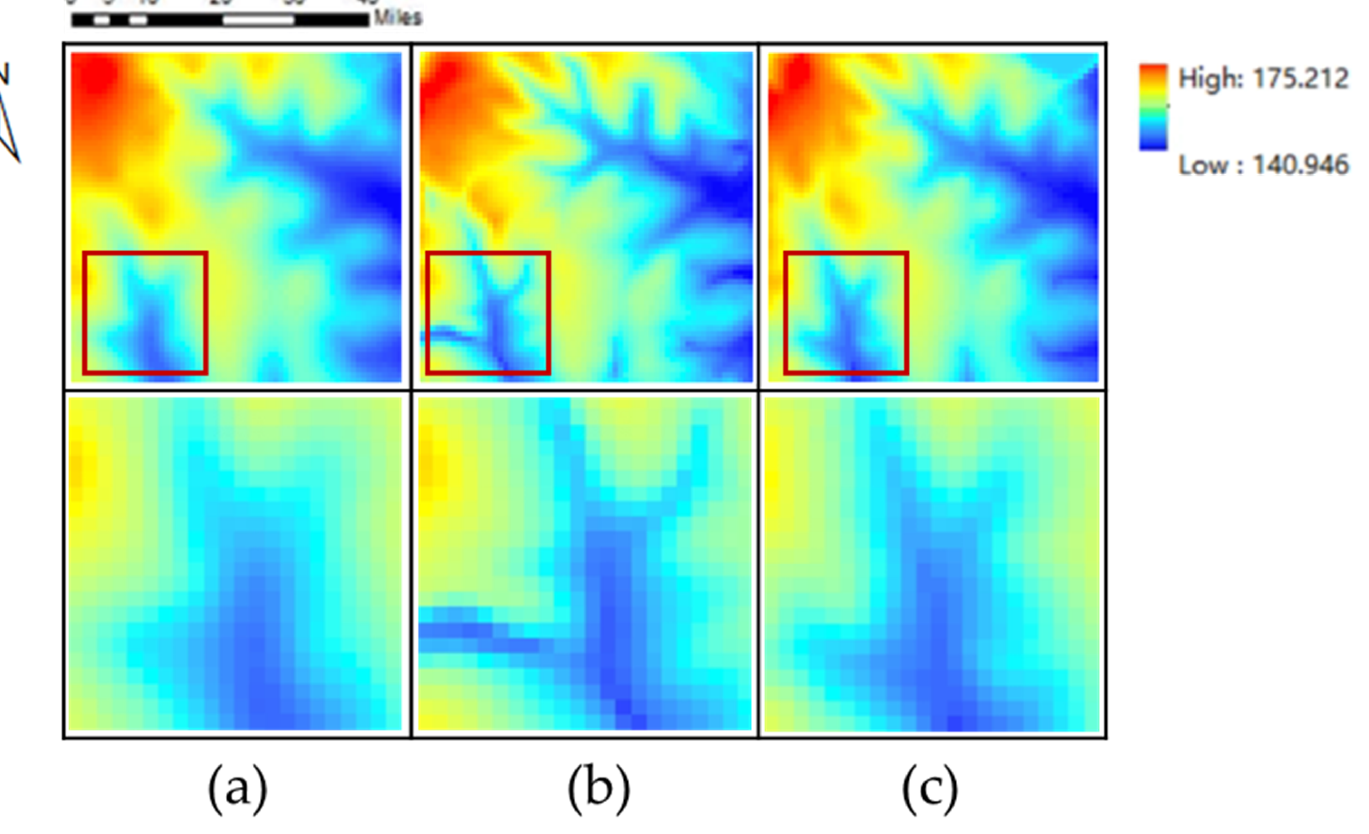
Figure 14. Global information supplement: ( a ) is the DEM has global information supplement, ( b ) is the DEM has not global information, and ( c ) is the ground truth (The details in the red box are in the next row). Table 3. The accuracy indicators of different loss